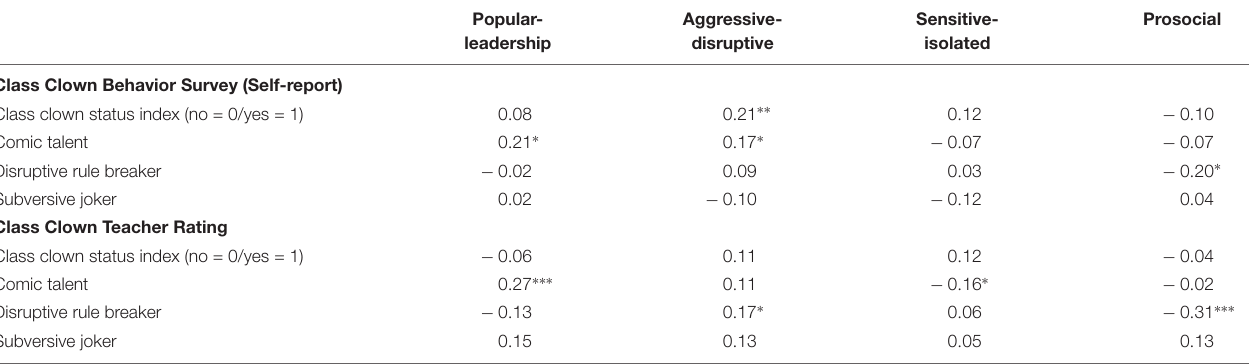
TABLE 5 | Results of multilevel models predicting dimensions of classroom behavior, as assessed by the revised class play (controlled for age and sex): Standardized coefficients for the fixed effects of the predictors of the respective random-intercept models for each block of predictors (self- and teacher-ratings of class clown behavior) entered simultaneously.